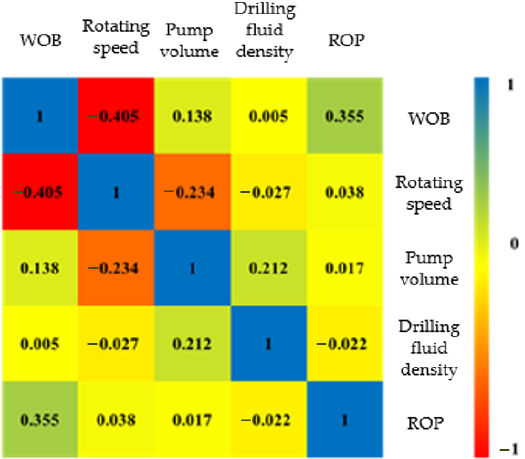
Figure 9. Lower part of Section 2 of Liushagang Formation.